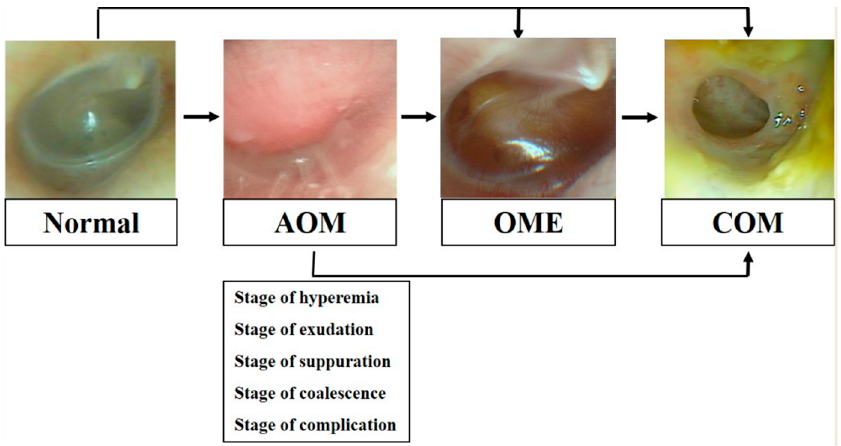
Figure 1. The progress of otitis media (OM).